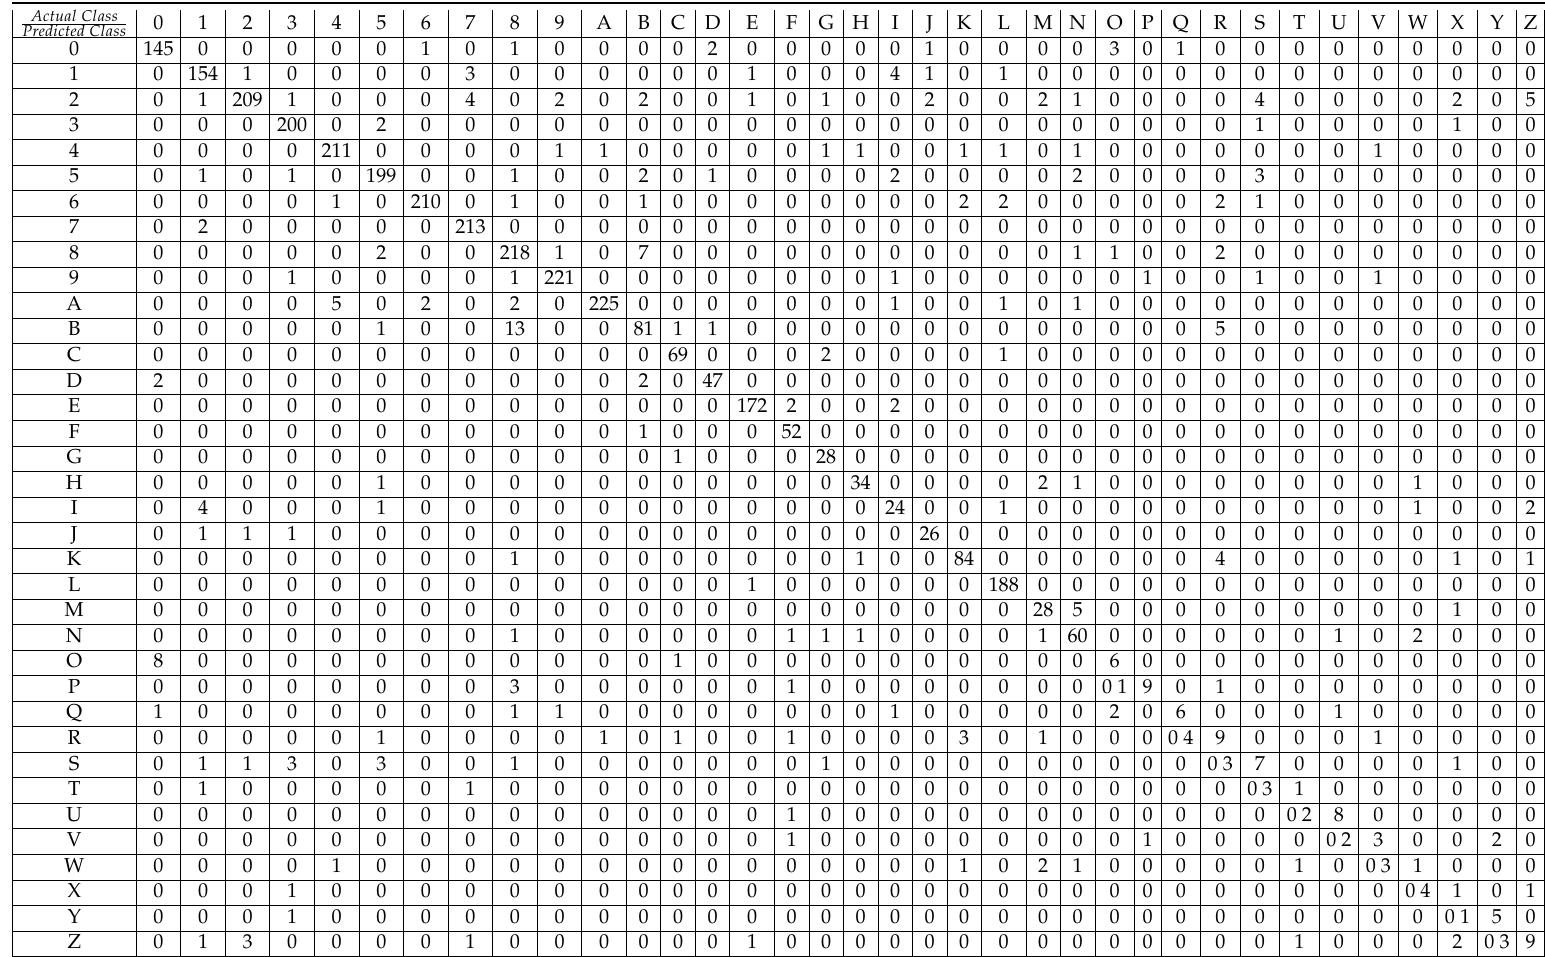
Table 5. Confusion matrix of OCR using MLP classifier